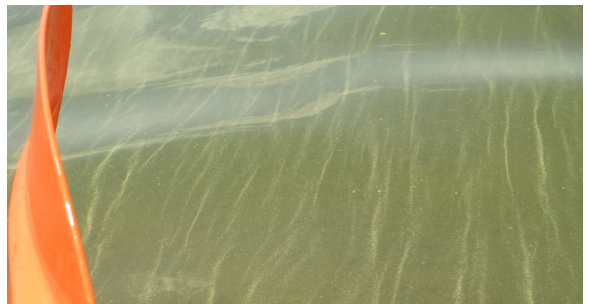
Figure 2. The presense of algaes and/or cyanobacteria was observed near sampling points 7 and 8.